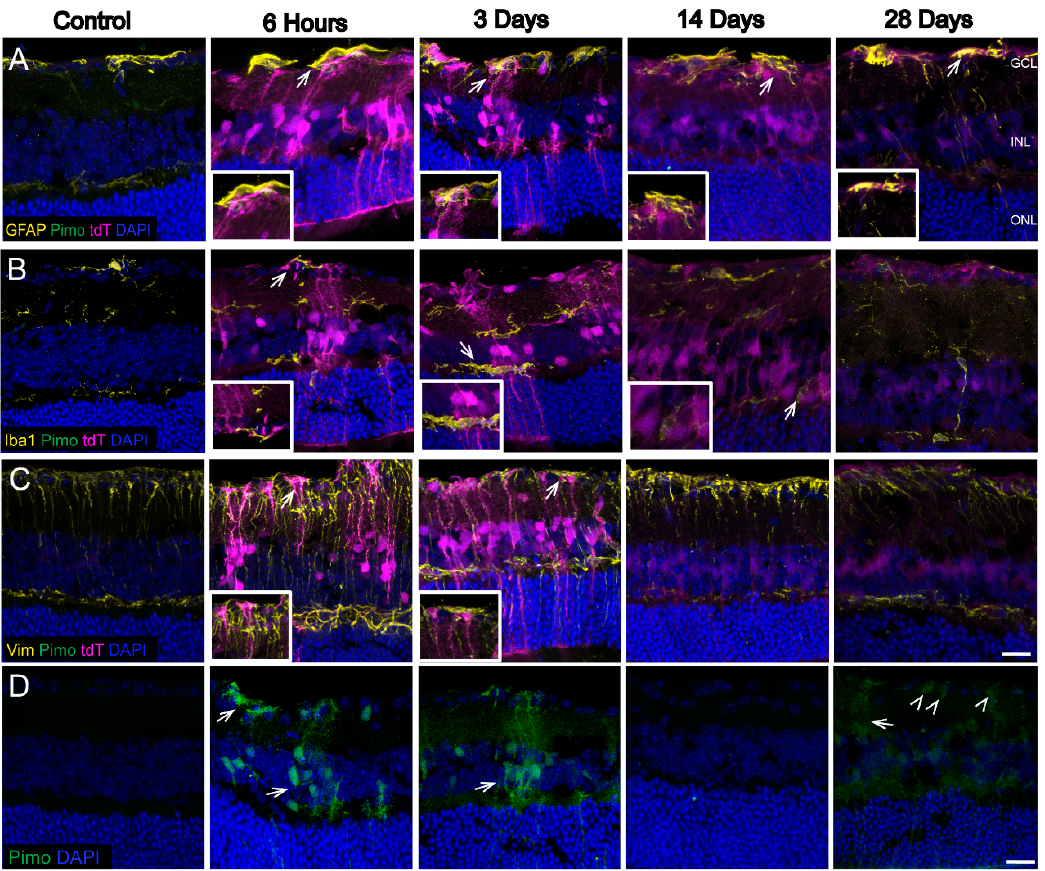
Figure 4. Hypoxic glia in the retina after OHT. Sagittal retinal sections were labeled with glial markers. ( A ). GFAP (glial fibrillary acidic protein, astrocyte marker, yellow) showed colocalization (arrows) with tdT (magenta) in GCL. ( B ). Iba-1 (ionized calcium binding adaptor molecule 1, microglia marker, yellow) showed colocalization (arrows) with tdT in INL. ( C ). Vim vimentin, Müller glia marker, yellow) showed colocalization (arrows) with tdT. ( D ). Pimonidazole (pimo, hypoxia marker, green, arrows) labeling was reported in Müller glia, and cells in GCL 6 h, 3 d, and 28 d after OHT. Pimonidazole was shown separately since it was overridden by tdT in previous images. tdT (tdTomato) expression (magenta), DAPI (cell nuclei, blue). Retinal layers were labeled as follows: GCL (ganglion cell layer), INL (inner nuclear layer), and ONL (outer nuclear layer). Scale bar: 25 µ m. n = 6 eyes at 6 h, 6 eyes at 3 d, 6 eyes at 14 d, 6 eyes at 28 d, and 10 control eyes. Insets represent a magnification of hypoxic